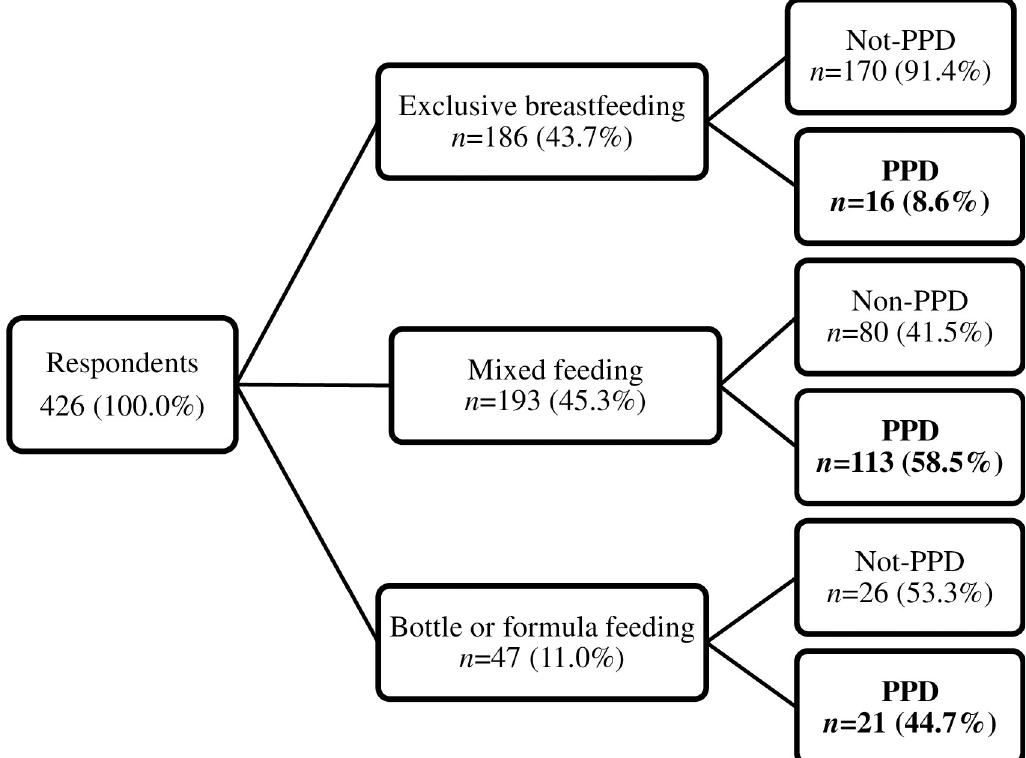
Fig 1. Frequency distribution of different feeding practices and the incidence of corresponding postpartum depression rate among postpartum women in Bangladesh ( N = 426).